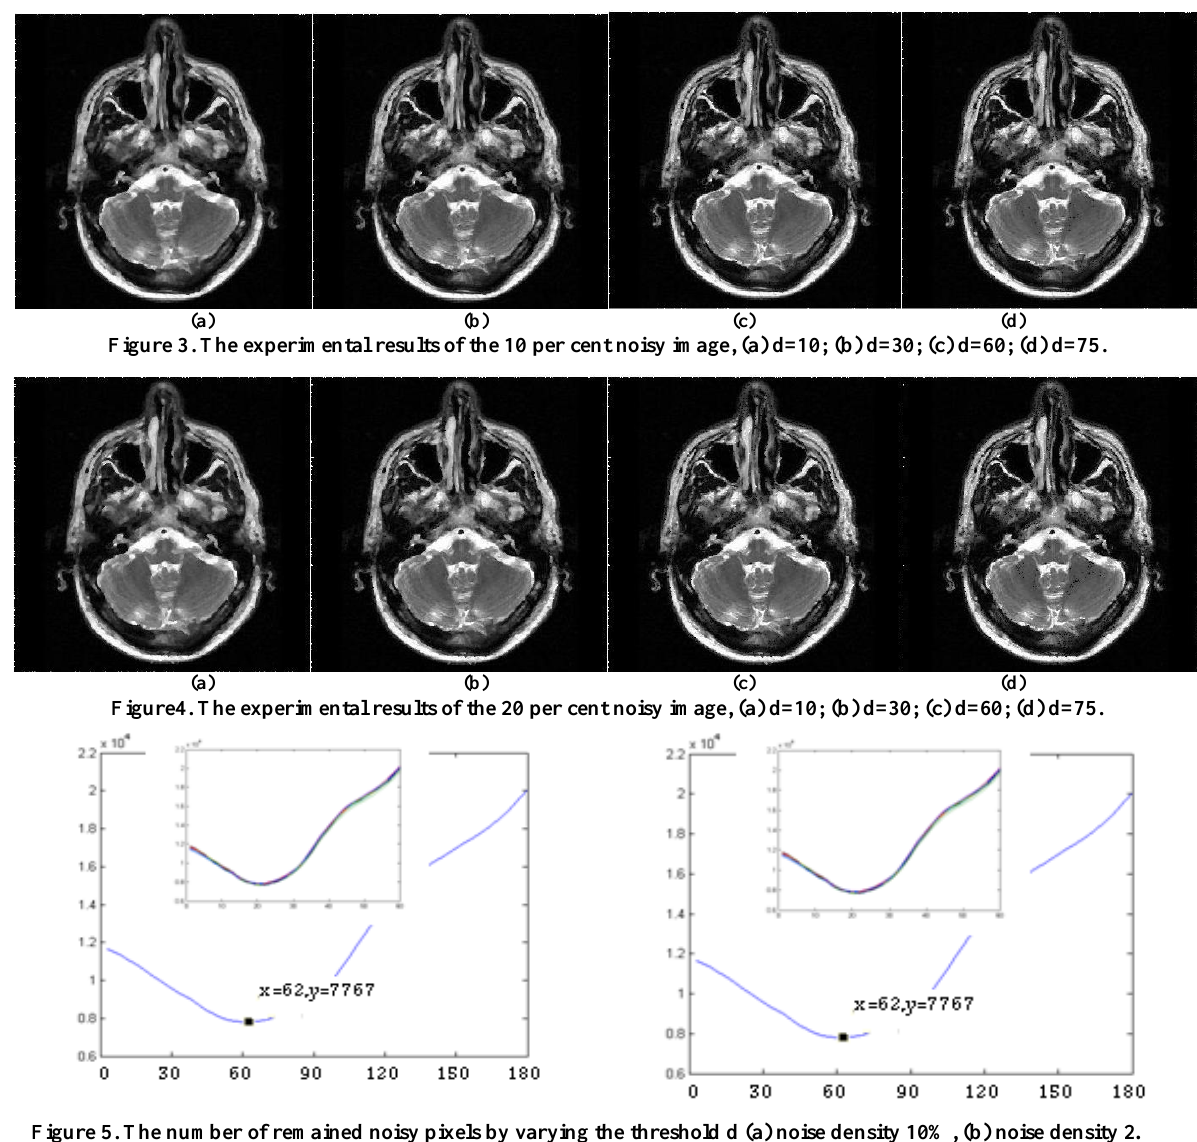
Figure 5. The number of remained noisy pixels by varying the threshold d (a) noise density 10%, (b) noise density 2.